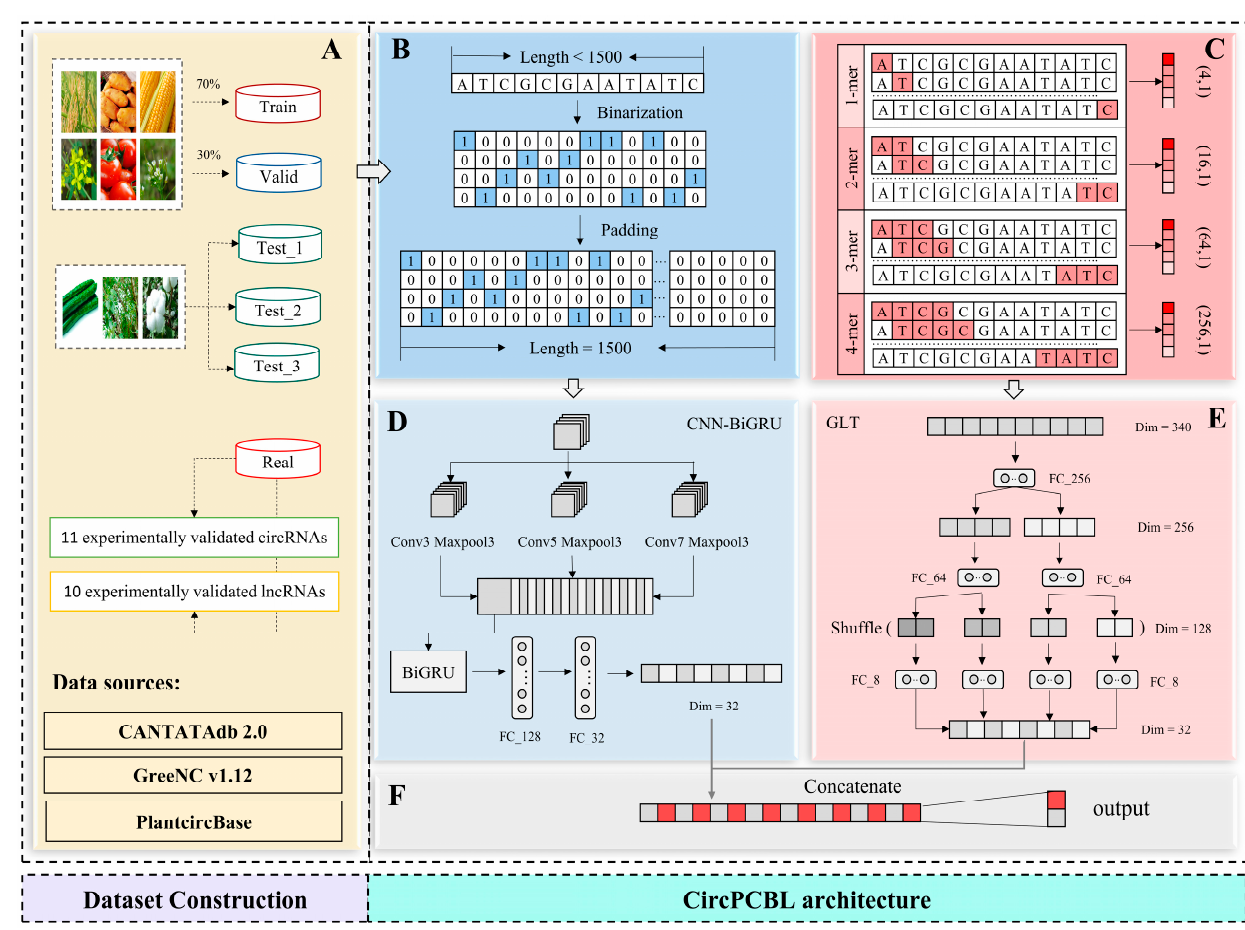
Figure 8. The flowchart for developing CircPCBL: ( A ) main datasets used in our work; ( B ) one-hot encoding process; ( C ) kK-mers features calculation process; ( D ) CNN-BiGRU model architecture; ( E ) GLT model architecture; ( F ) result output process.